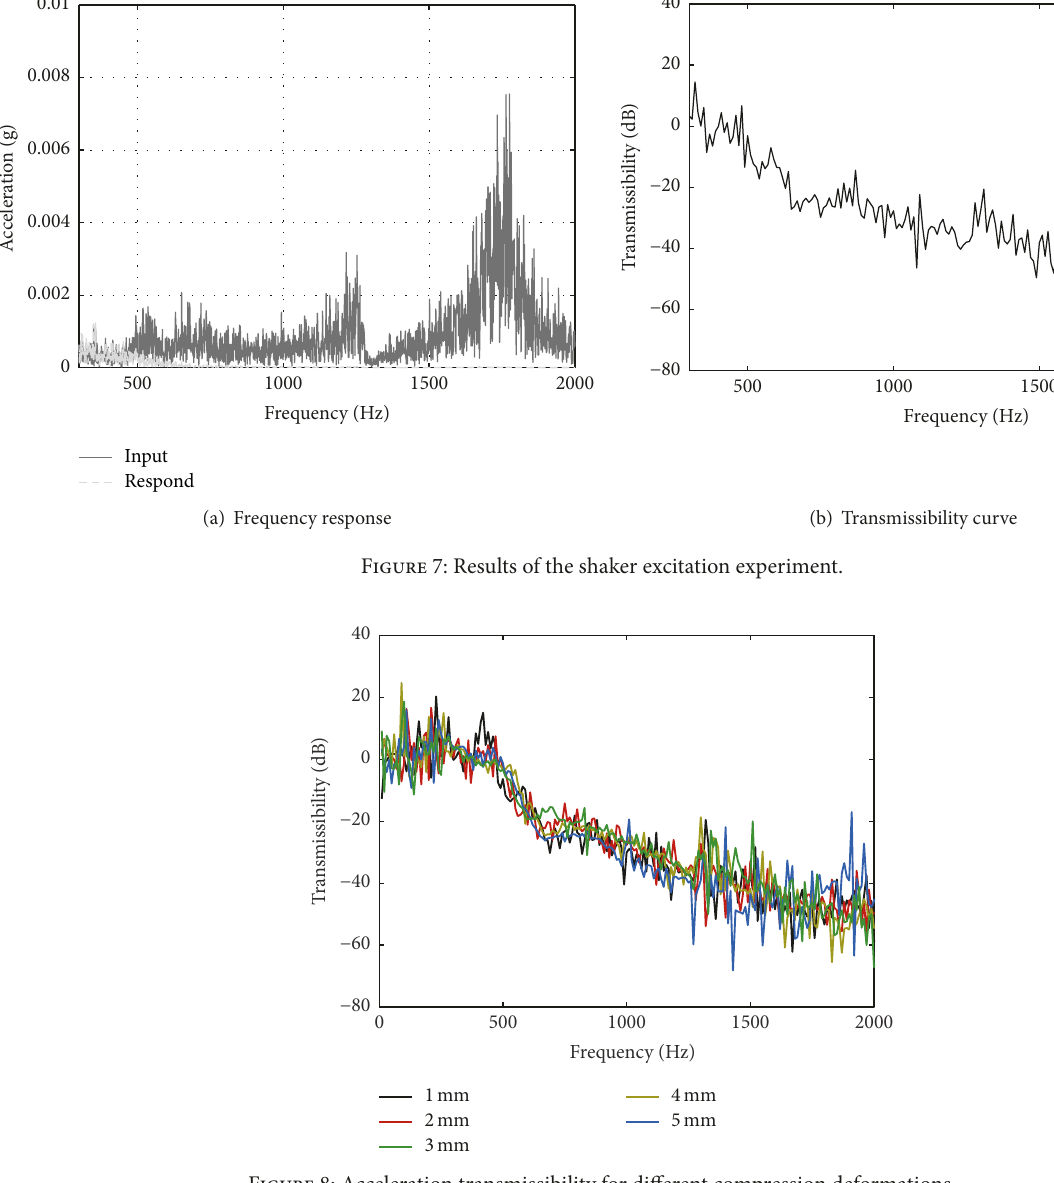
Figure 8: Acceleration transmissibility for different compression